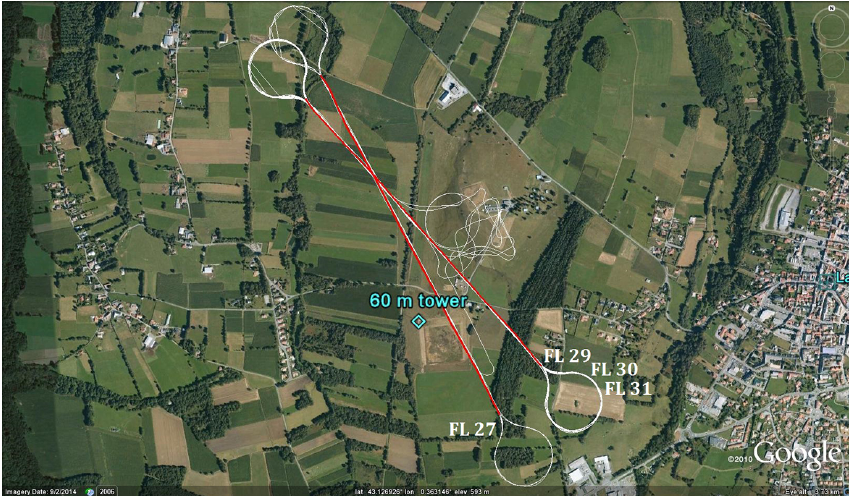
Figure 3. Flight path of the four SUMO flights, no. 27 (65ma.g.l.), 29 (65ma.g.l.), 30 (70ma.g.l.) and 31 (70ma.g.l.), in the vicinity of the 60m meteorological tower (blue diamond) situated at Site 1. The straight legs used for calculation of turbulence parameters are marked in red. Each leg is approximately 1km long. Satellite picture from Google Earth.